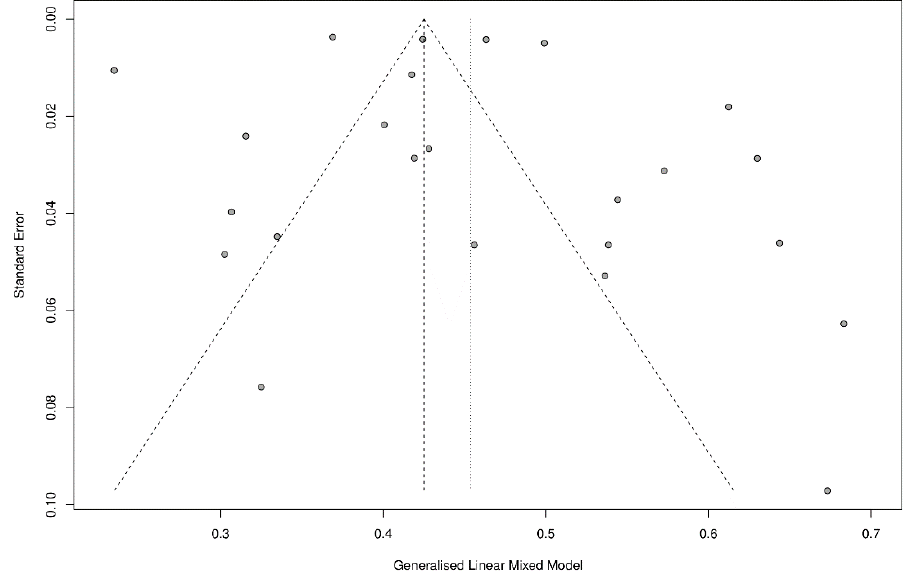
Figure 4. Funnel Plot of Incidence of New-Onset Diabetes After Transplantation (NODAT) at 1-year After Liver Transplantation.